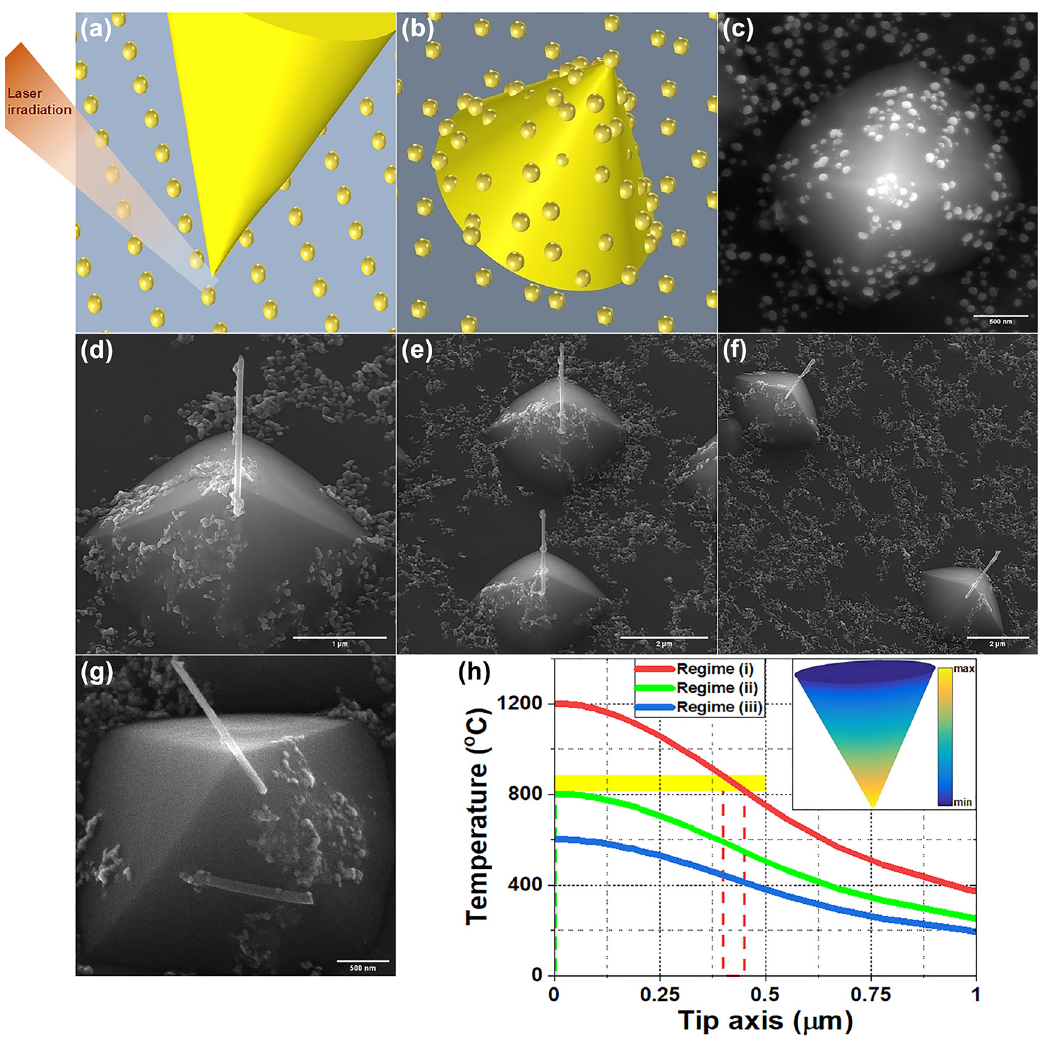
Figure 8: Controllability of the localized growth in the second designed ONF-CVD process. (a, b) Schematics to demonstrate conditions for the activation of only one catalyst nanoparticle as a result of the near-field induced heat generation, either locating just below the tip (a), or locating on the apex of a nanotip (b). (c) Corresponding to the schematic indicated in (b), SEM image of a fabricated silicon nanotip (in an array) containing dispersed Ni nanoparticles all over the apex and sidewalls of the tip as well as the substrate surface. (d–f) Controlled growth of individual well-aligned nanotubes for the fabrication of CNT-tips based on applying ONF-CVD process to the nanotip array with dispersed catalyst nanoparticles all over. (g) SEM image of the undesired regime (i), mentioned in the context, for an applying laser power of 70 W, showing the role of irradiation laser power in the performed ONF-CVD process. (h) The resulting temperature profiles along the axis of a simulated Si tip with 10 nm Ni cladding, indicating the three mentioned regimes in the experiments. The yellow strip shows the temperature range desired for the CNT growth on the tip. The dashed green and red lines show the regions of the tip in regimes (ii) and (i), respectively, where the nanotube can be grown. The inset shows a typical 3D temperature profile of the